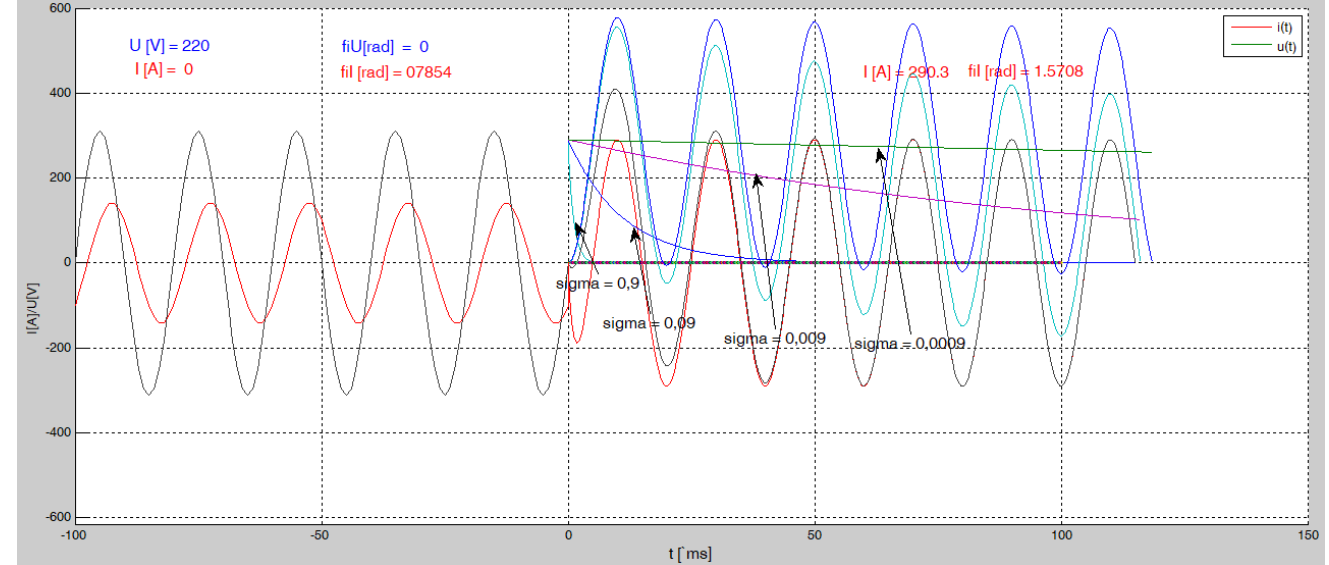
Figure 11. The voltage and current variation for inductive load, ɸ Idef = π /2, Idef = 290.3 A; over time, t ∈ ( − 100,100) ms for σ = 0.9, σ = 0.09, σ = 0.009 and σ = 0.0009.